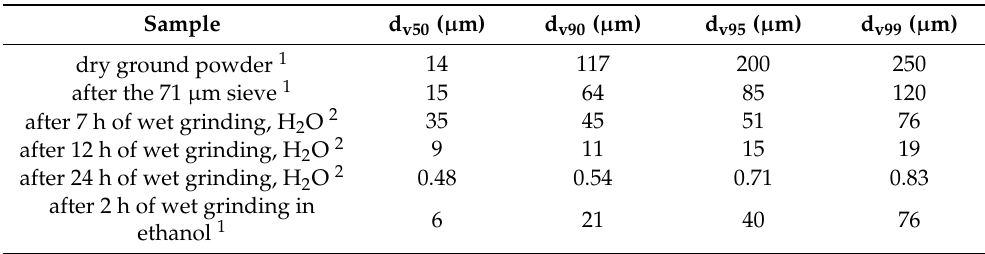
Table 1. Parameters for the volume- weighted cumulative PSDs of PbO·ZnO·P 2 O 5 glass powders prepared after different stages of grinding.